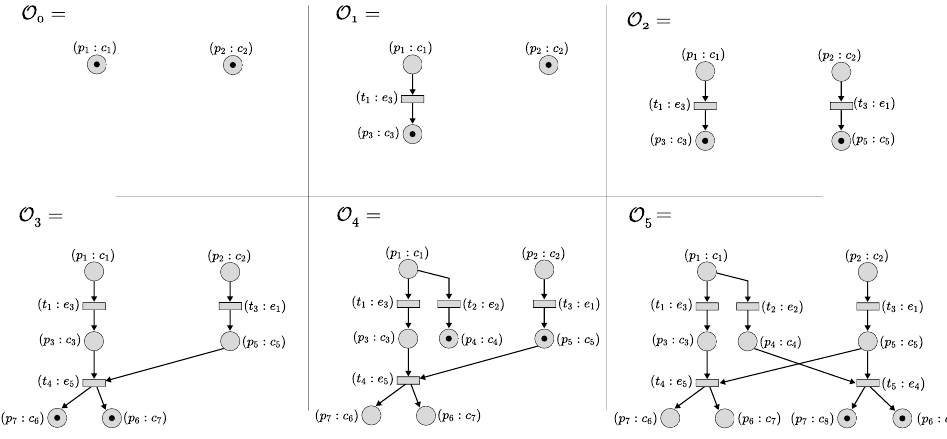
Figure 4. An iterative illustration of the unfolding process of the net system in Figure